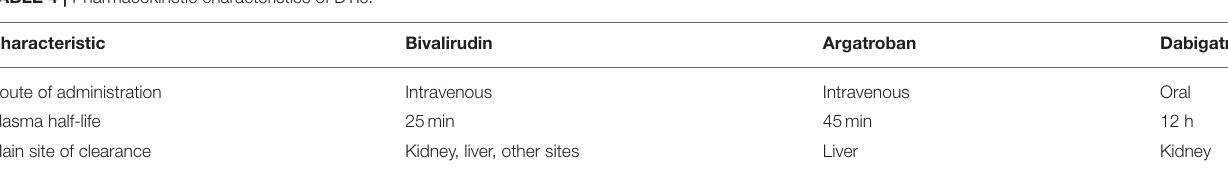
TABLE 4 | Pharmacokinetic characteristics of